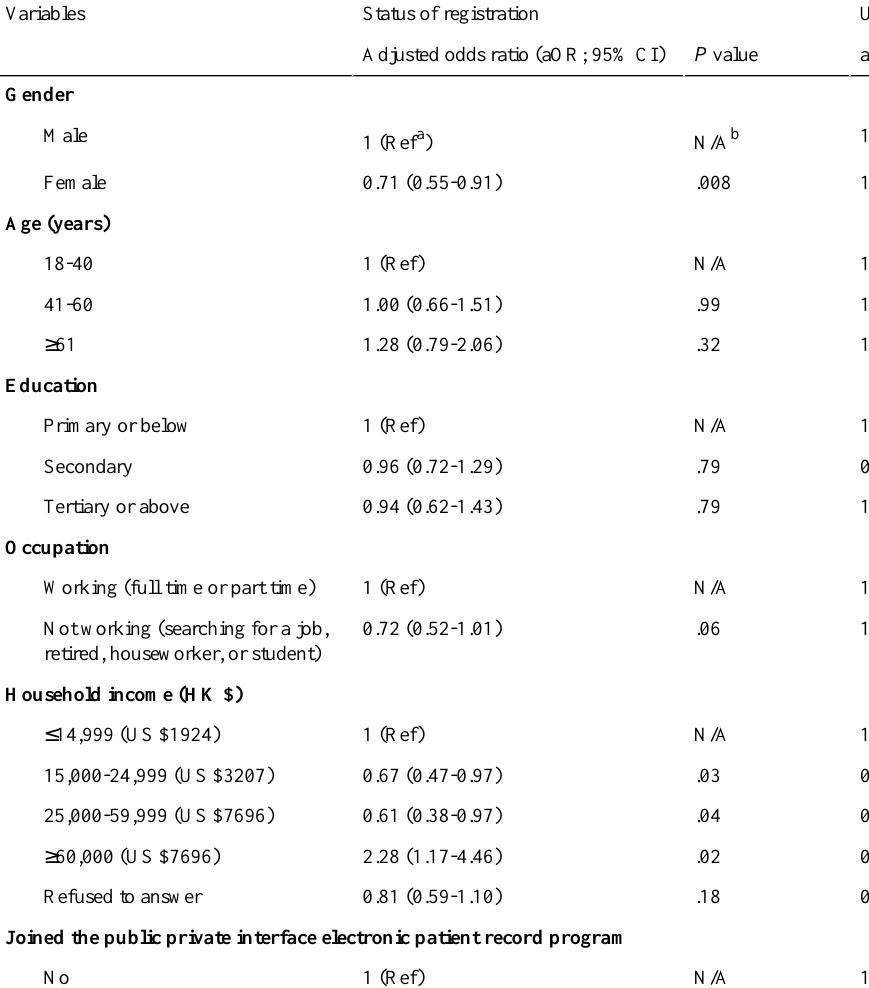
Usage of the systemStatus of